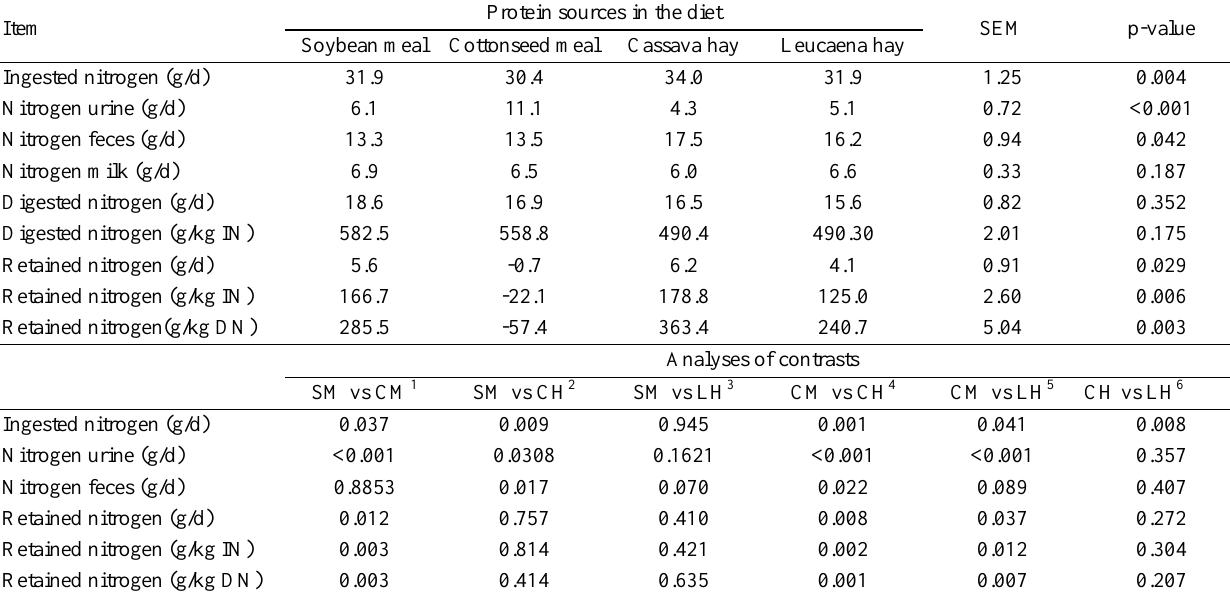
Protein sources in the